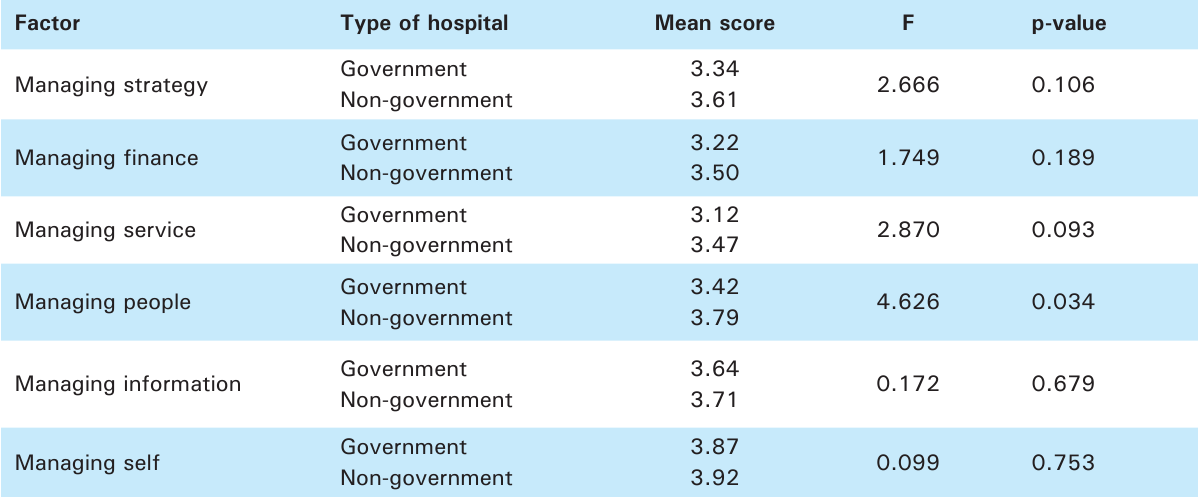
Table 4. Bivariate relationship between type of hospital and management capability (ANOVA)